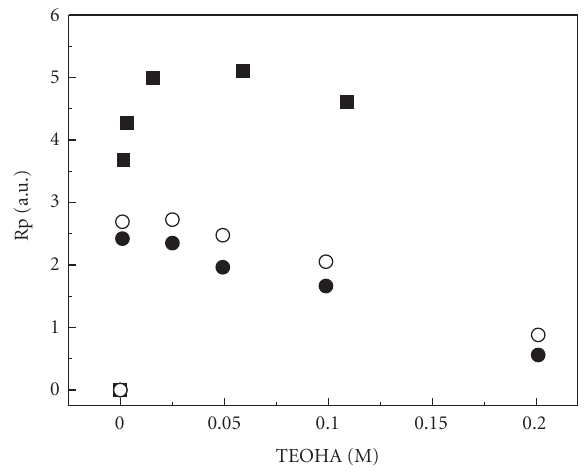
Figure 5: Polymerization rate (Rp) as a function of TEOA concentration. In the absence of OS ( • ), in the presence of TPS ( ◦ ) and in the presence of DPI ( (cid:2) ). Saf: 1 × 10 − 5 M and OS: